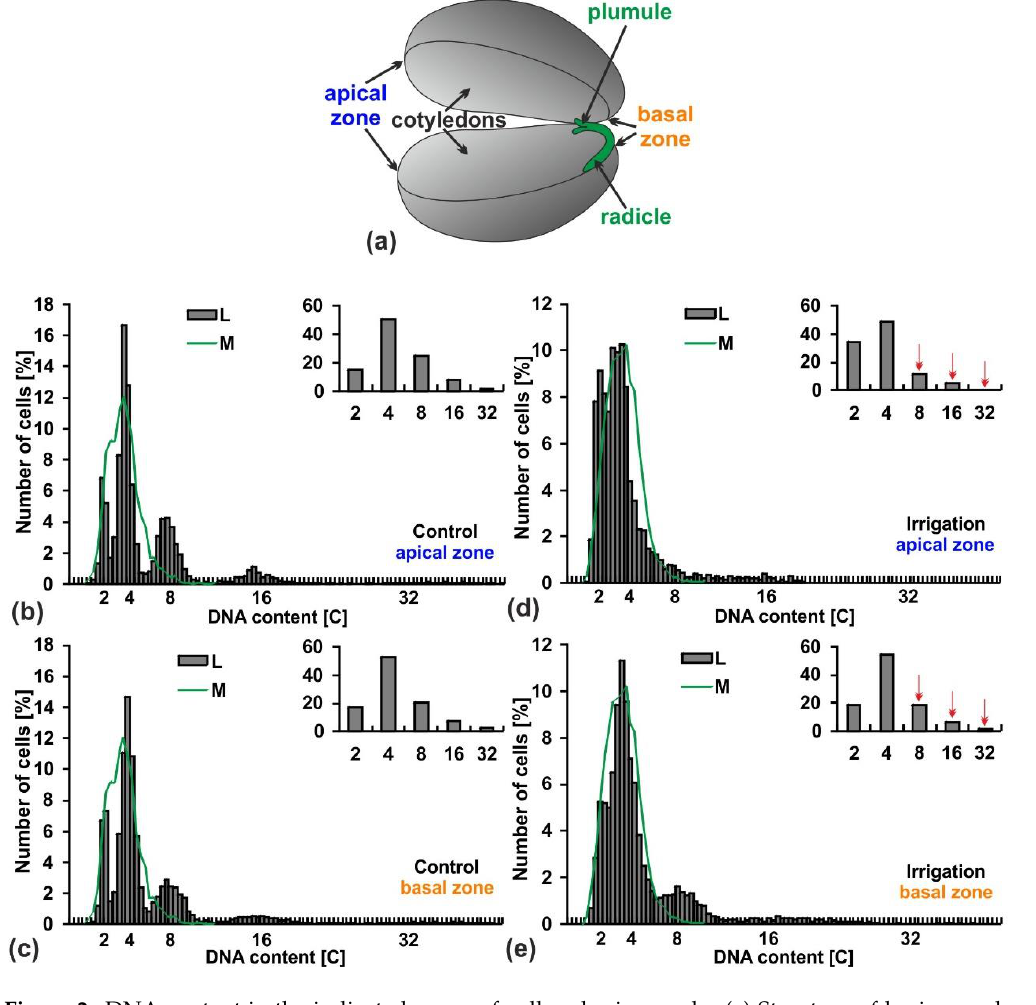
Figure 2. DNA content in the indicated zones of yellow lupine seeds. ( a ) Structure of lupine seed. ( b – e ) Frequency distribution [%] of nuclear DNA content in the selected zones: cotyledon zones (L) and root meristems (M) of yellow lupine; ( b ) Apical zone of control seeds from not irrigated plants. ( c ) Basal zone of control seeds from non-irrigated lupine plants. ( d ) Apical zone of seeds from irrigated plants. ( e ) Basal zone of seeds from irrigated plants. Inserted bar graphs show percentages of cells after successive rounds of endoreplication. Red arrows show a decrease in the number of polyploid cells in the seeds from irrigated plants.